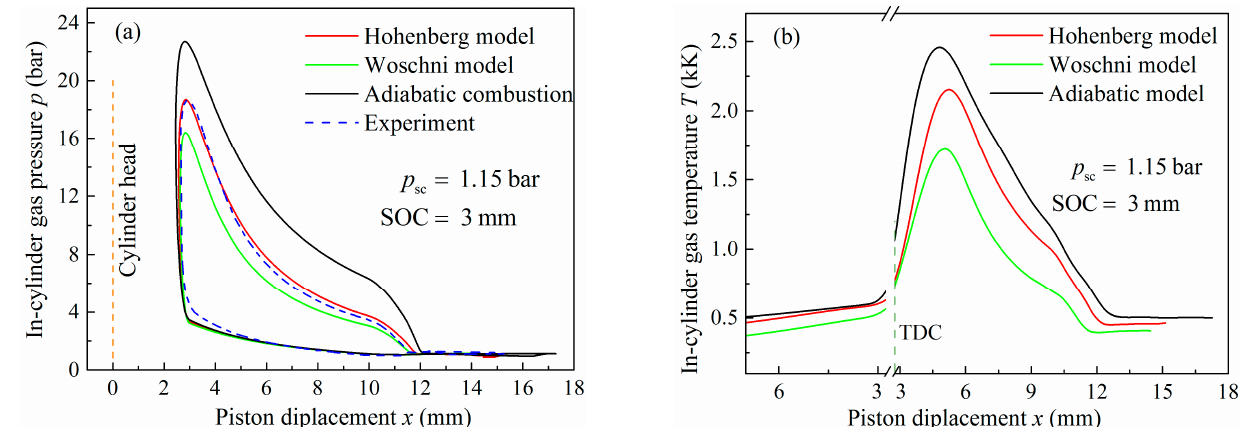
Figure 4. Heat transfer model vs. the pressure and temperature of in-cylinder gas. ( a ) In-cylinder gas pressure vs. piston displacement; ( b ) In-cylinder gas pressure vs. expanded piston displacement.